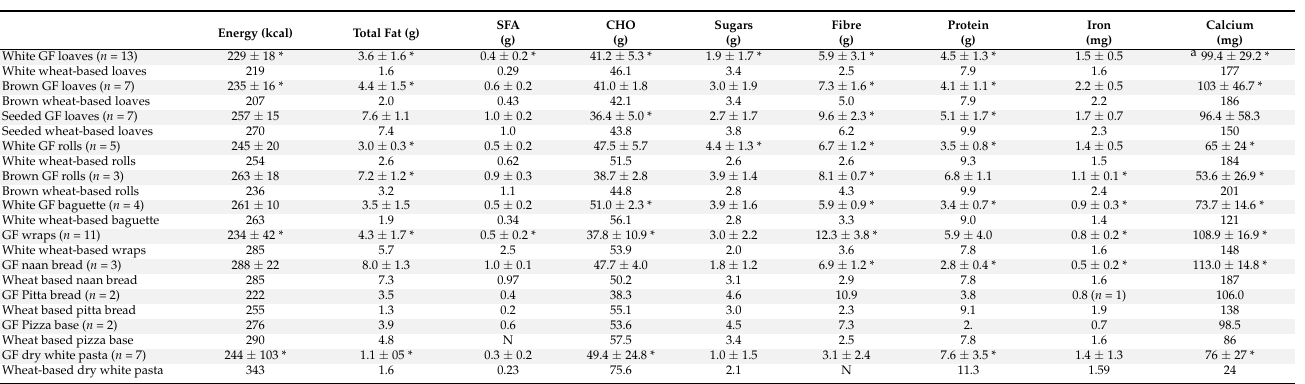
Table 1. Mean nutrient composition of gluten-free and wheat-based breads and pastas per 100 g.